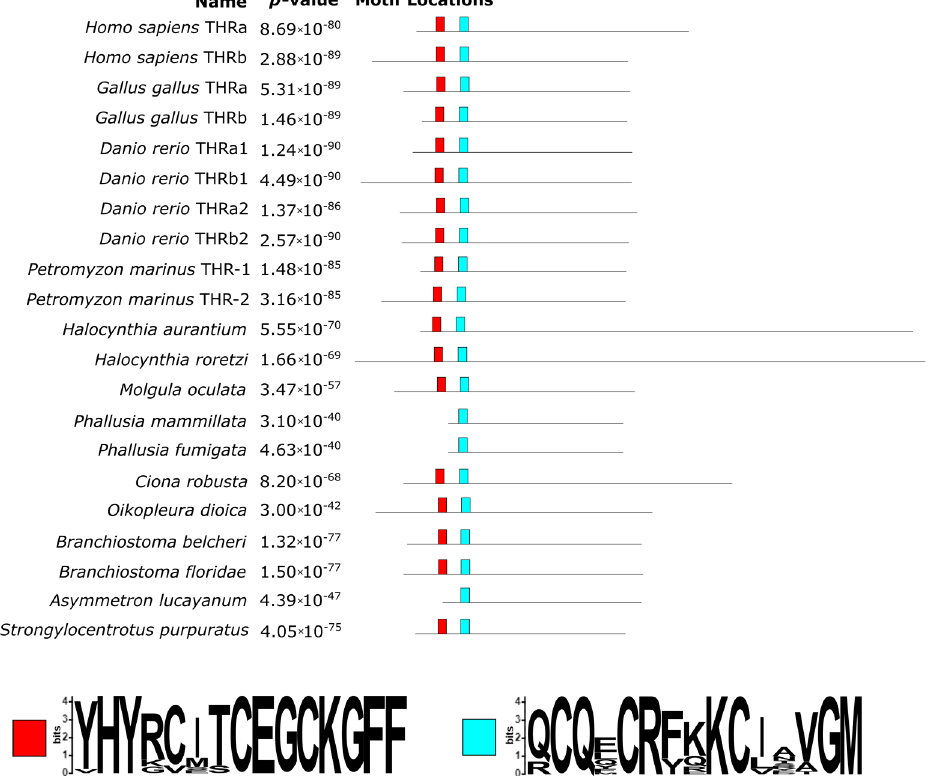
Figure 7. Conserved domain locations and SeqLogo as inferred by the MEME suite on the THR protein sequences. The proteins were aligned to highlight the occurrence and positioning of the conserved domains. The position of the boxes reflects the actual positions in the alignment (see Supplementary Materials Figure S5). The N-terminal DNA-binding domain contained two conserved sequences, a P-box motif (red) and a T-box/A-box motif (light blue).